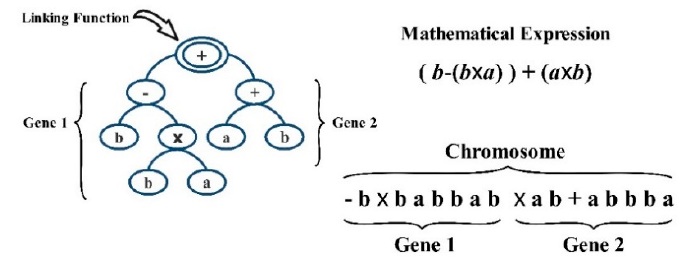
Figure 2. Expression tree and mathematical function of two gene chromosome.